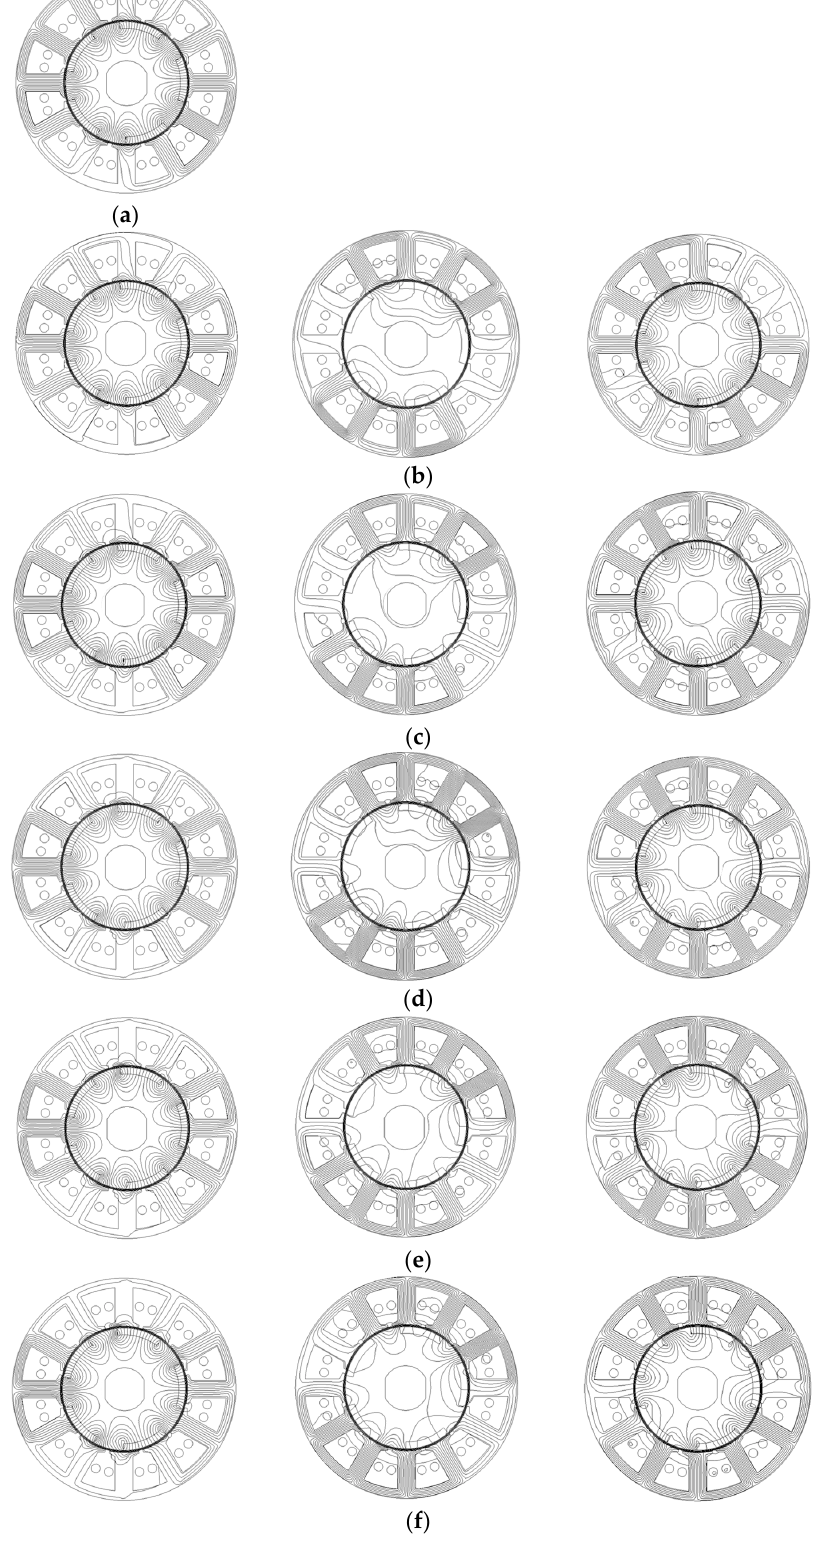
Figure 9. Equal potential distributions for 12s10p-CCPPM. (from left to right: PM only, armature current only, overall) ( a ) 0A. ( b ) 10A ( c ) 20A. ( d ) 30A. ( e ) 40A. ( f ) 50A.